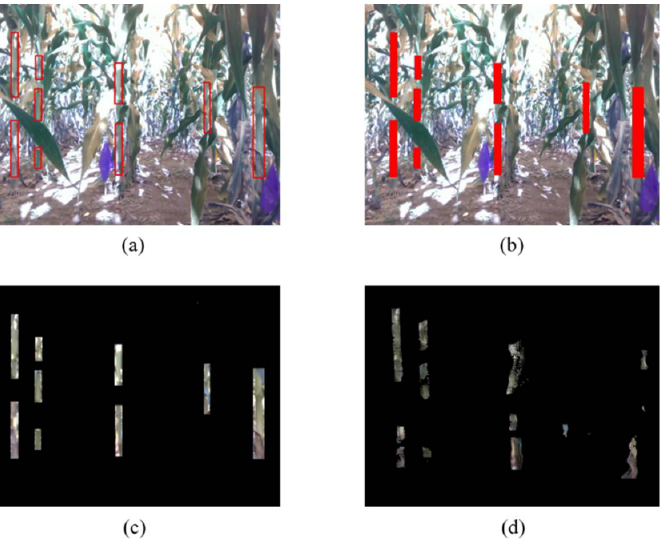
Figure 11. The loss curve and PR curve after model convergence.